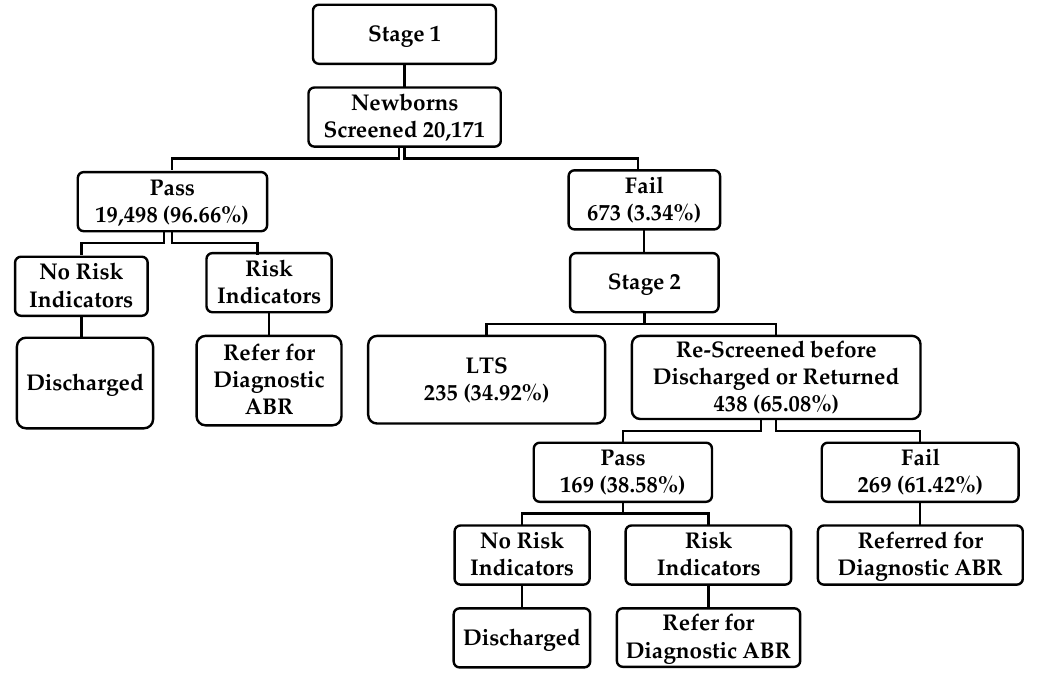
Figure 1. The pass and referral rates of the two-stage NHS protocol used in two Saudi hospitals. Note: LTS: Lost to system; ABR: Auditory brainstem response.